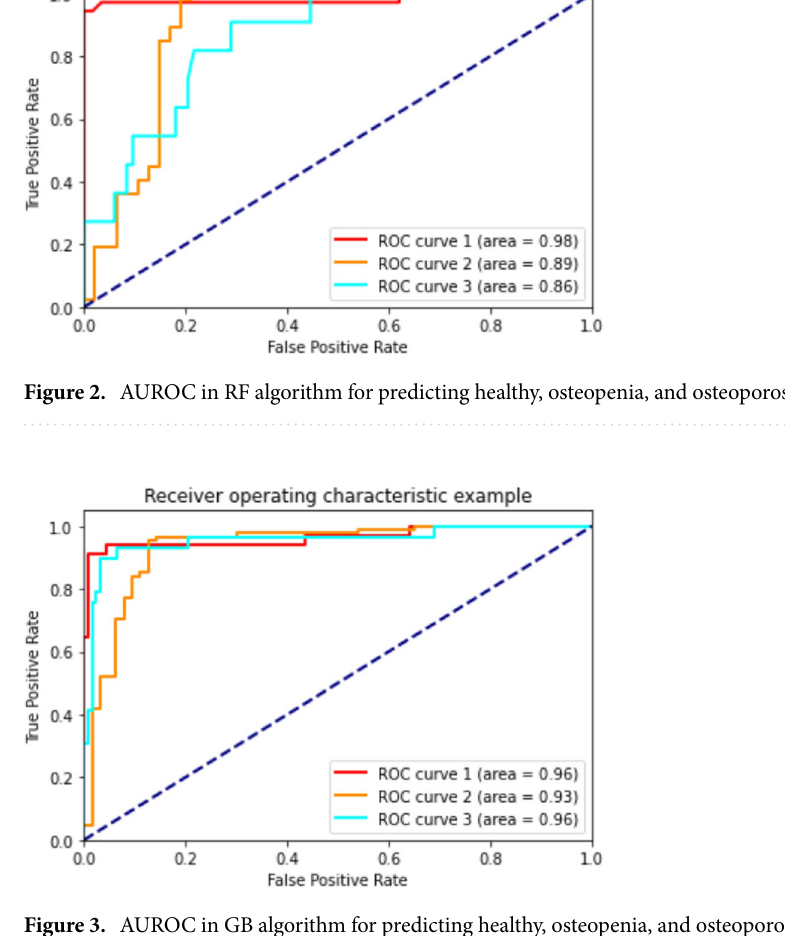
osteopenia, and osteoporosis. To predict healthy, osteopenia, and osteoporosis in women, machine learning models achieved an accuracy of 75–93%, a precision of 74–93%, a sensitivity of 75–91% and a specificity of 82–95%. In addition, the AUROC between machine learning models were compared. The RF algorithm showed the highest performance in the men group with AUROC 0.91, and in the women’s group, the GB algorithm with AUROC 0.95 performed best. The ROC curves of different models of machine learning in men and women are presented in Figs. 2 and 3 (Table 4).